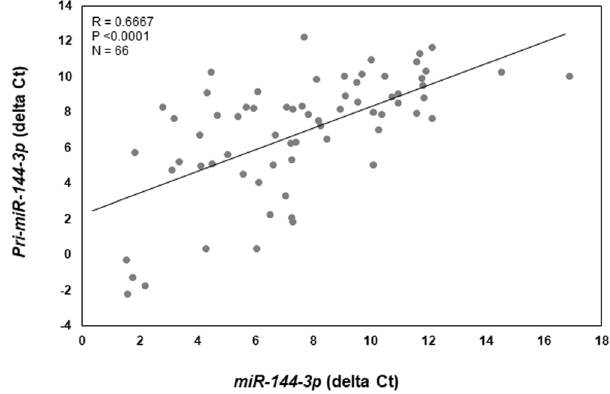
Figure 2. Correlation between mature miR-144-3p and pri- miR-144-3p in individual endometriotic lesions. Delta ct values (mature miR-144-3p or pri- miR-144-3p – U58) were plotted and Spearman’s correlation coefficient was calculated. There was a significant positive correlation in lesion expression between mature- and pri- miR-144-3p .